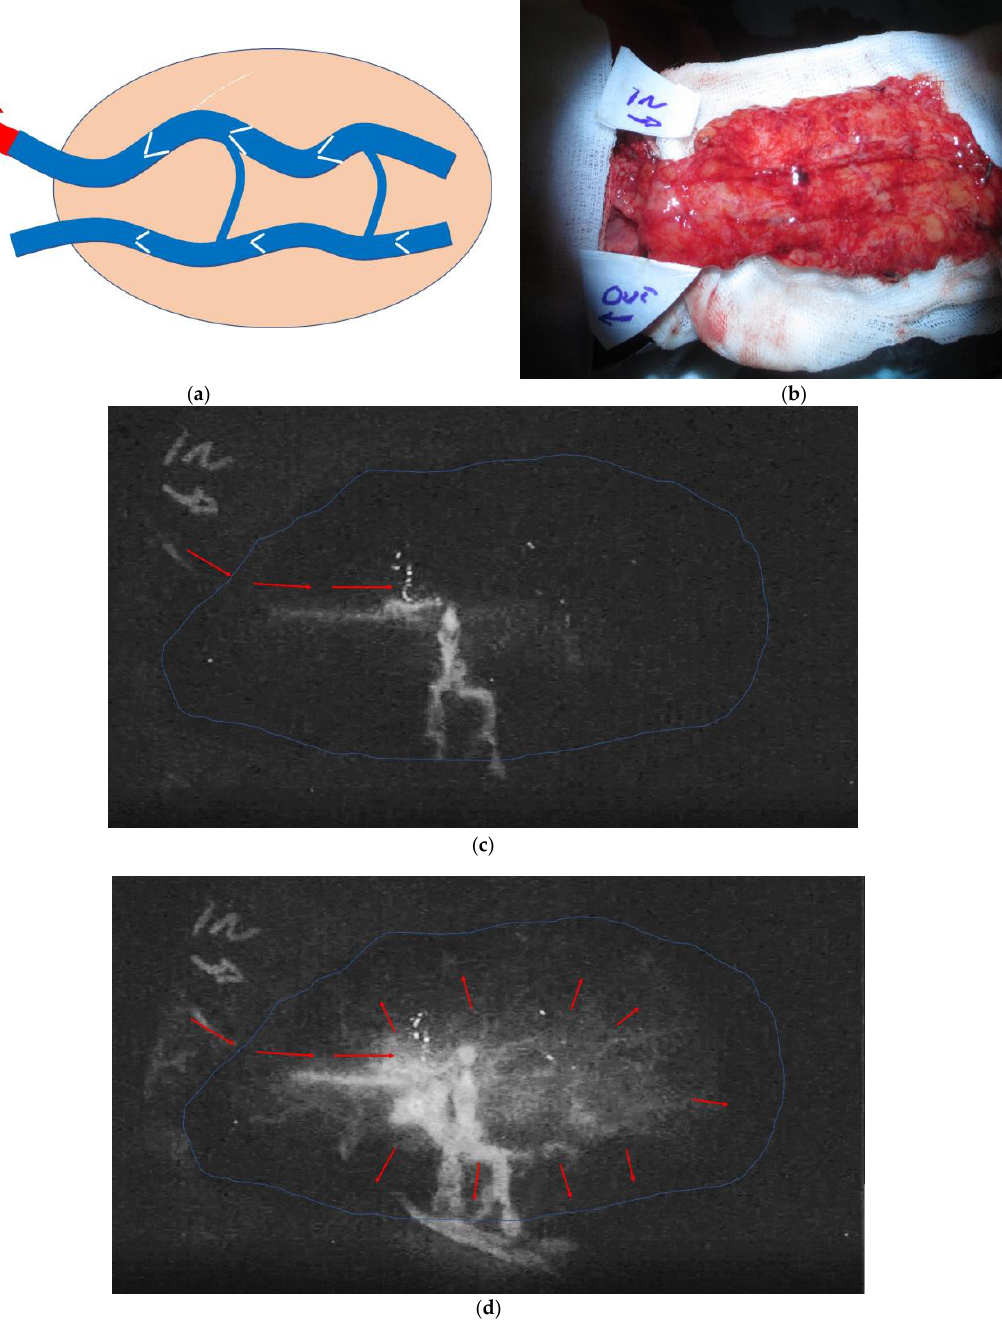
Figure 1. ( a ) In the retrograde free venous flaps, the input arterial flow (red arrow) is entering the flap through a vein against the valve; ( b ) In this case, more detailed in Figure 2, the flap was studied upside down with ICG green to document the revascularization pattern once the artery and the draining vein were sutured; ( c ) the same flap at time 0, when the ICG started flowing into the arterialized vein; ( d ) The flap after 5 min with diffuse revascularization. The strong stream signal in the centre is a leak from the arterialized vein.